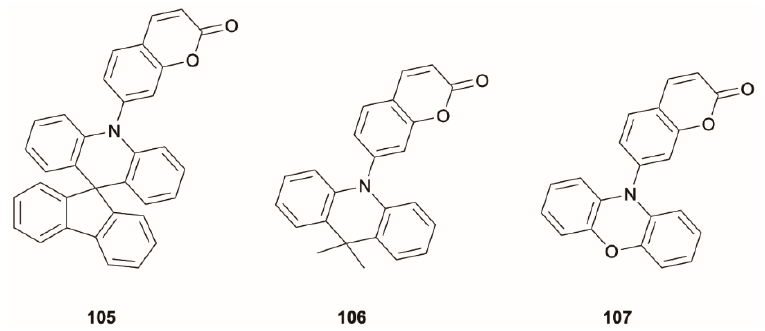
Scheme 36. Chemical structure of compounds 105 – 107 .